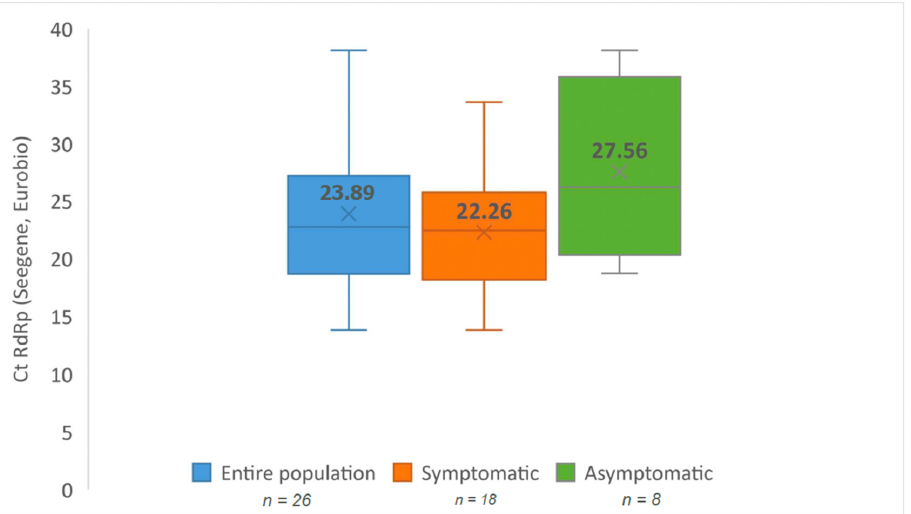
Figure 6. Box plots of Ct RdRp distributions in different groups. Ct RdRp distributions in the entire population ( left ), symptomatic group ( middle ) and asymptomatic group ( right ). Table 2. RdRp Ct values and diagnostic accuracy of RT-LAMP considering different patient groups.